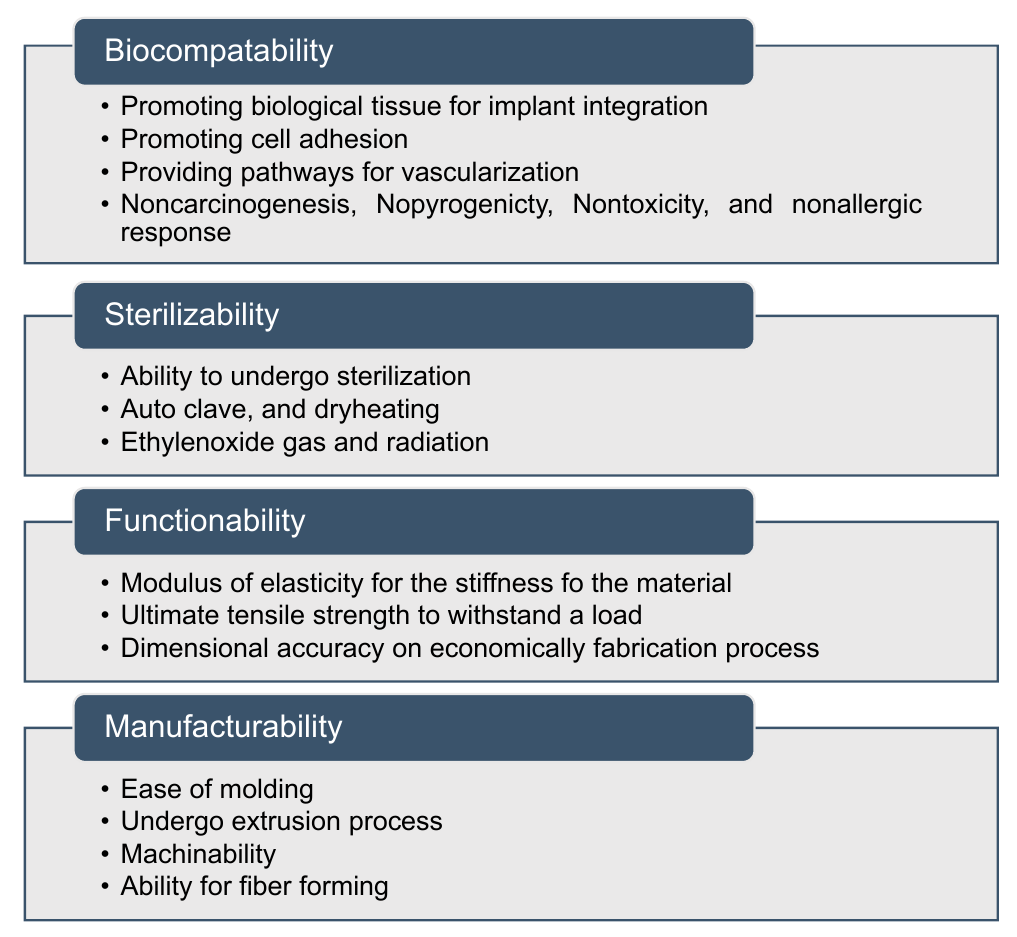
Figure 3. Properties of nanocomposite materials for medical applications. Table 1. Micro and nanocomposites performed by AM medical implants.